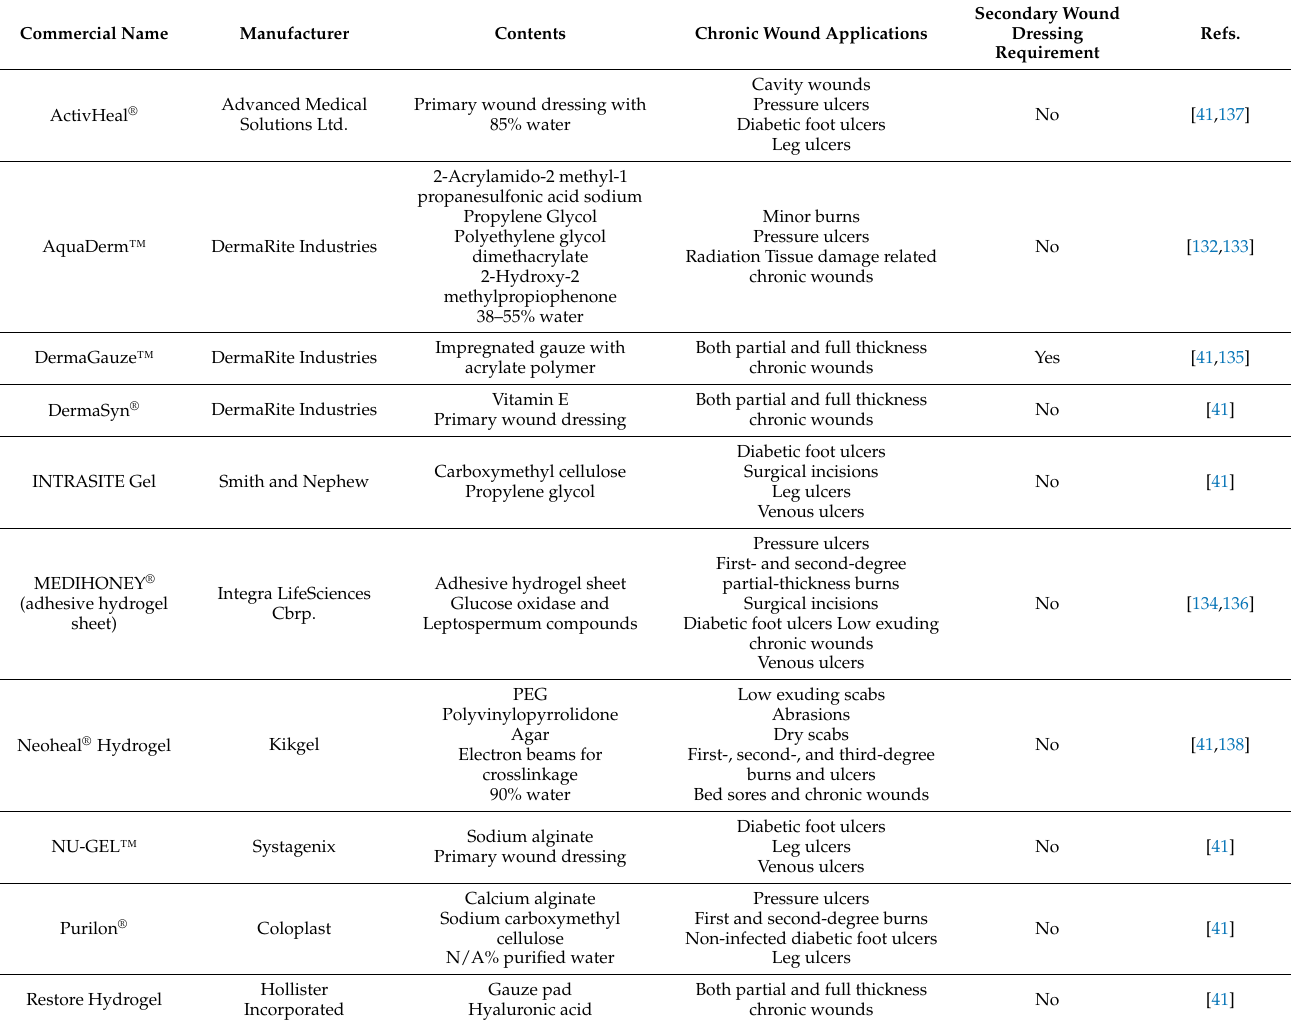
Table 5. Commercially available hydrogel wound dressings for chronic wound